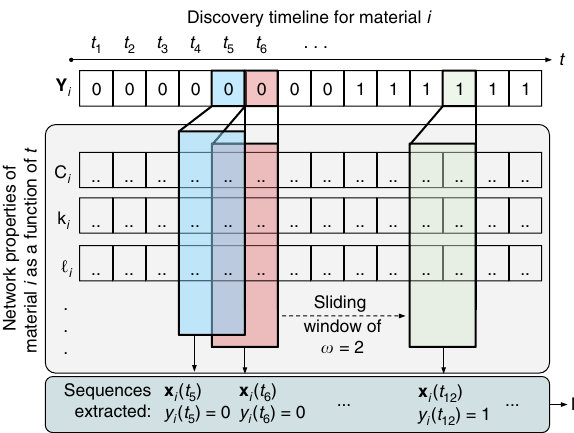
Fig. 5 Extraction of sequences from temporal network property data using a sliding window to use as input for machine learning. The vector Y i stores the targets to be learned for material i , i.e., encoding whether i is discovered by a given time-step t or not (as binary labels 1 and 0). C i , k i , and ‘ i are examples for vectors of different network properties, encoding how those properties change over time as the network evolves, as explained in the text. The process of applying a sliding window (here with a width of w = 2) to extract sequences of features and targets ( x i , t , y i , t ) is illustrated. ML stands for the machine-learning task of training and testing classi fi cation algorithms using the extracted